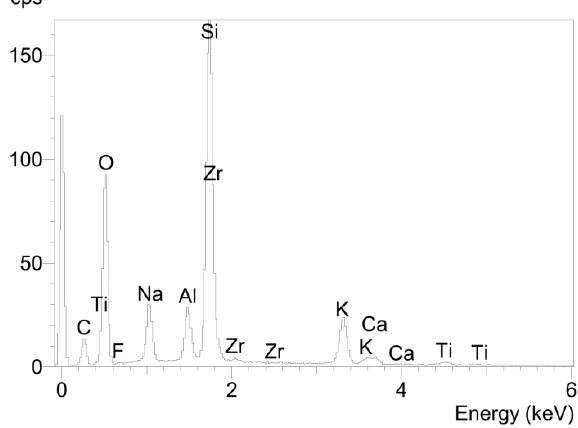
Figure 7. SEM images of the fractured surface of 5_Ti_gs at magnifications of ×50 ( a ) and ×1000 ( b ).